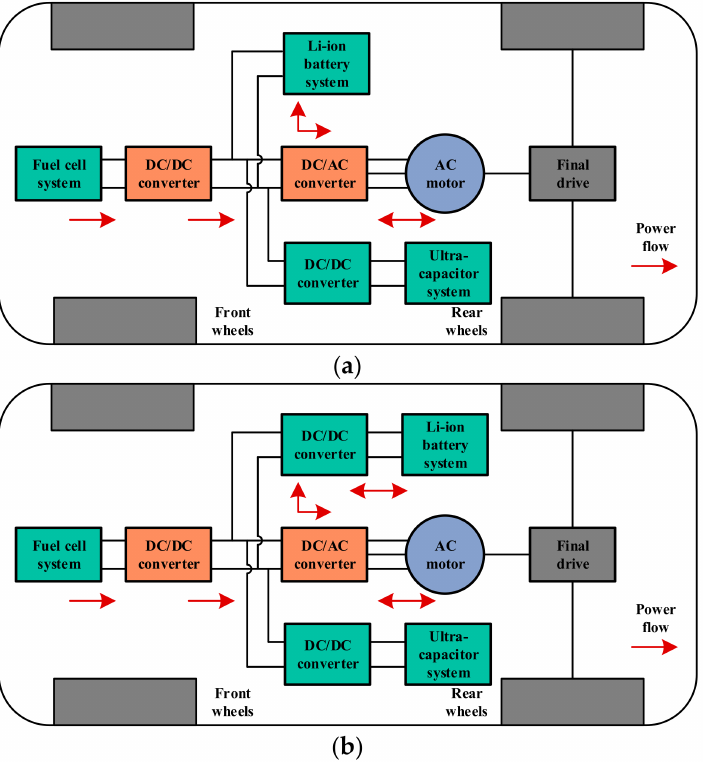
Figure 5. Topologies of FC + battery + UC: ( a ) battery disconnected to the DC/DC converter; ( b ) battery connected to the DC/DC